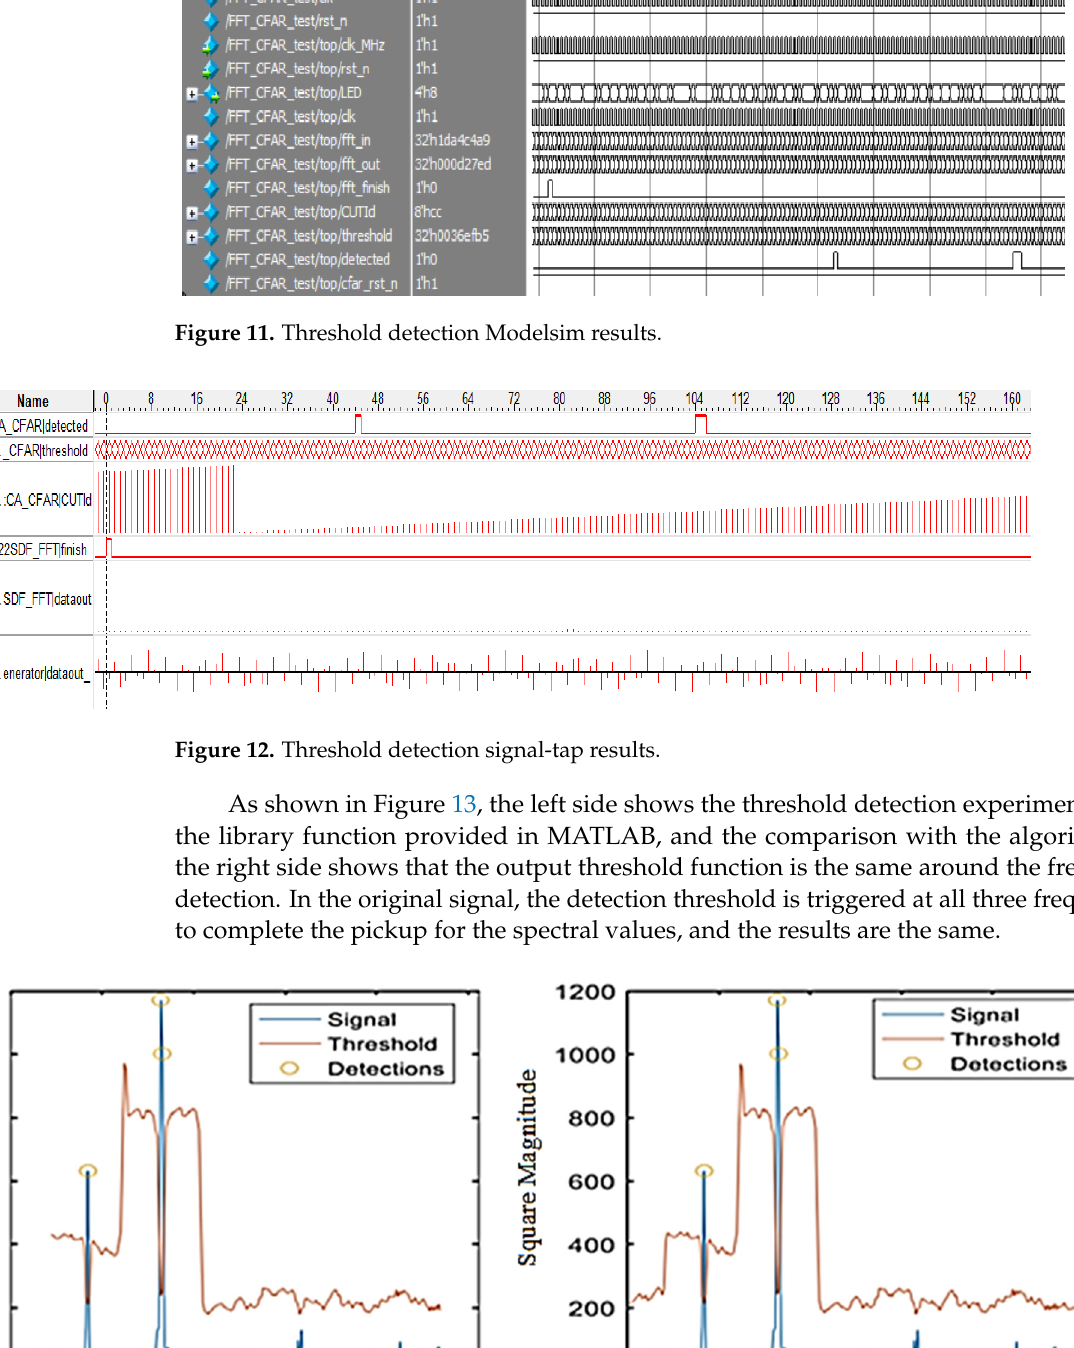
Figure 14. Threshold detection resource occupancy. 4.2.2. Moving Target Detection To carry out the software detection process of the moving target detection module, the input signal used is still a sine wave, and here a linear FM signal method is used to modulate the carrier frequency, because such signals have better resolution for moving targets. The detection of multiple targets can be achieved at increased distances, and the signals selected have different energies. Figure 15 depicted the effect of the input signal after filtering by moving target de- tection, where there are two signals in each group, the upper one is the input signal of the module, and the latter is the output signal. Figure 16 shows the image of the initial part of the signal after amplification in the previous figure, and it can be seen that the signal grad- ually stabilizes after the moving target detection module.